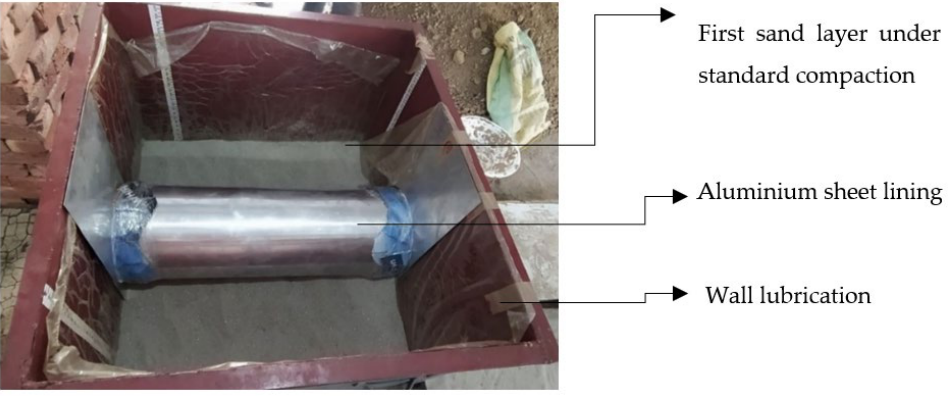
Figure 5. Placement of lining.